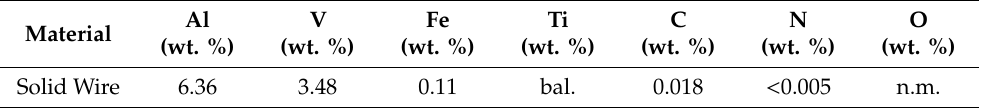
Table 1. Measured chemical composition of applied titanium alloy wire AWS A5.16 ER Ti5 (EN ISO 24034); n.m.: not